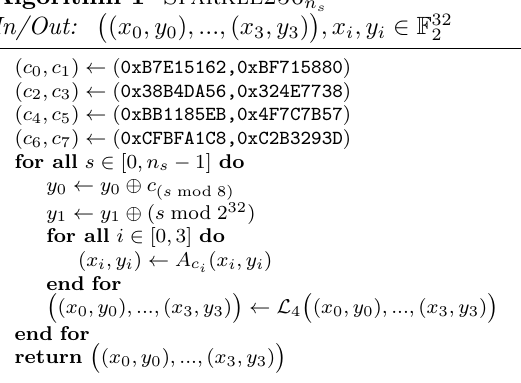
Algorithm 1 Sparkle256 𝑛